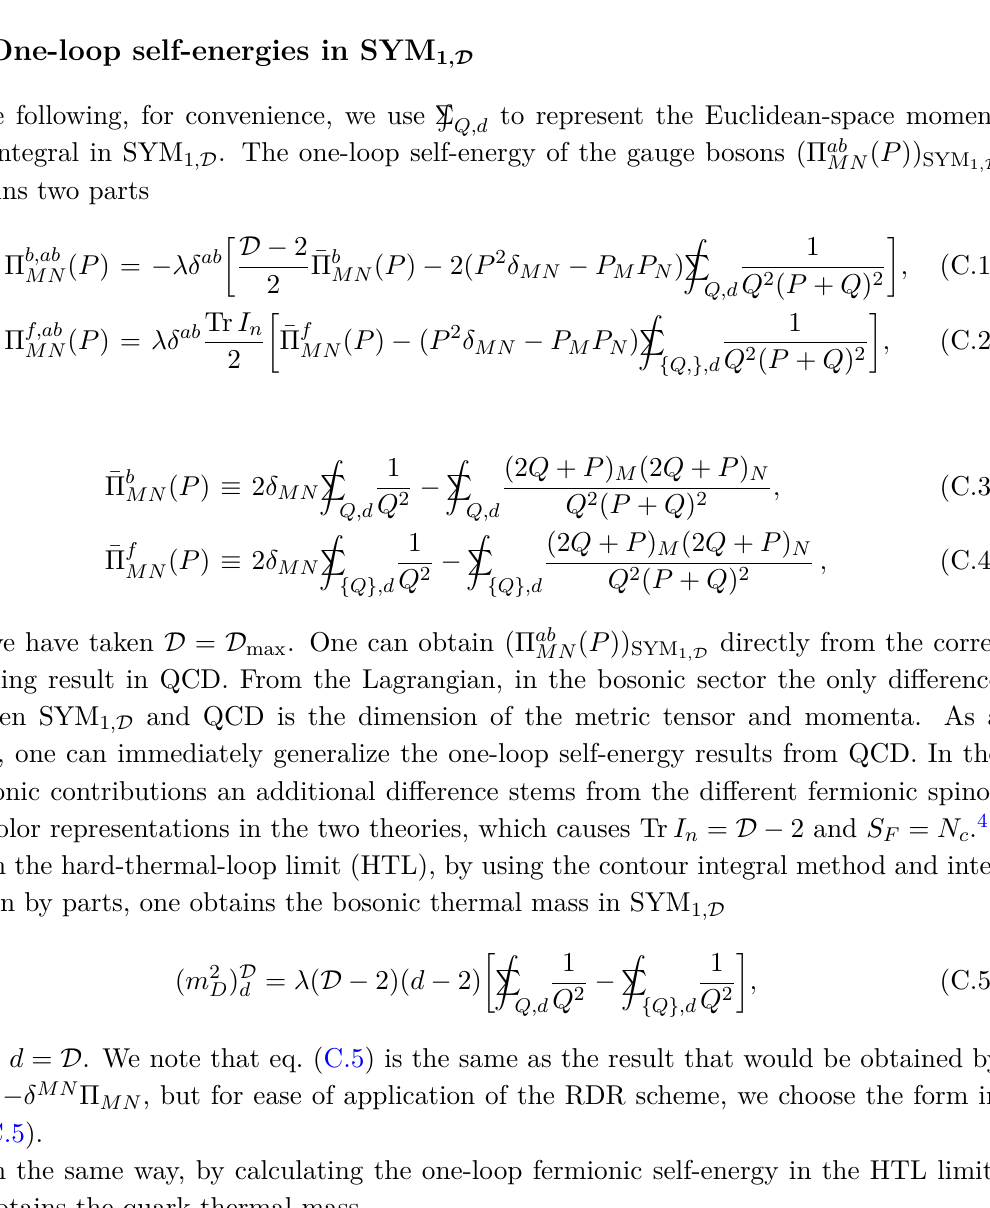
Figure 6 . The one-loop self-energy of N = 1